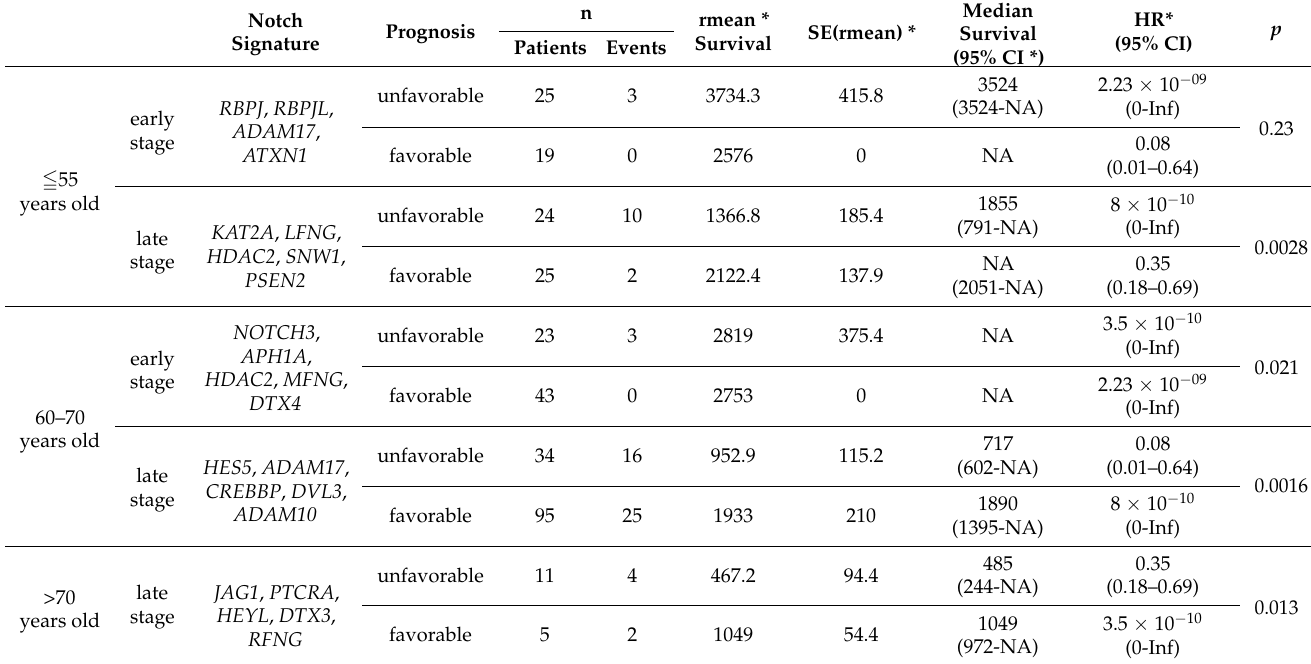
Table 5. The Notch signature specific for each PC subgroup significantly differentiates